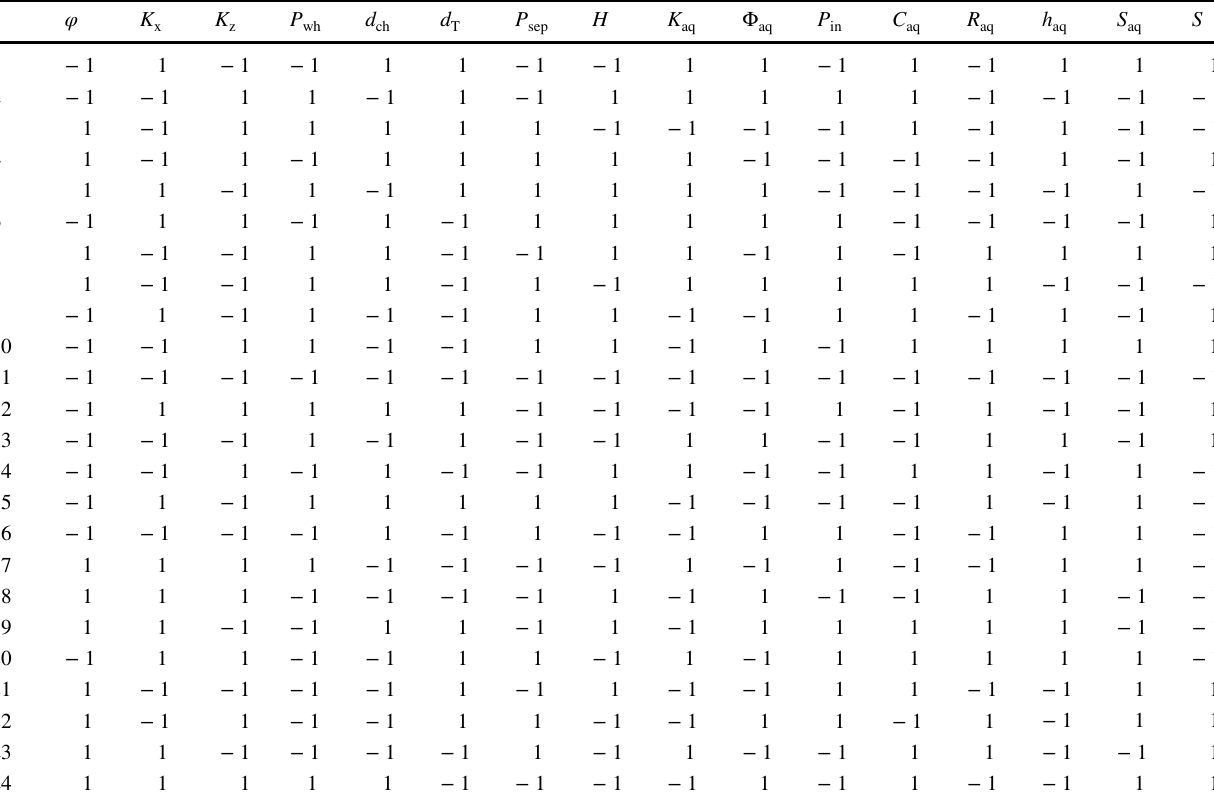
Table 8 The order and design of the experiment by Plackett–Burman method